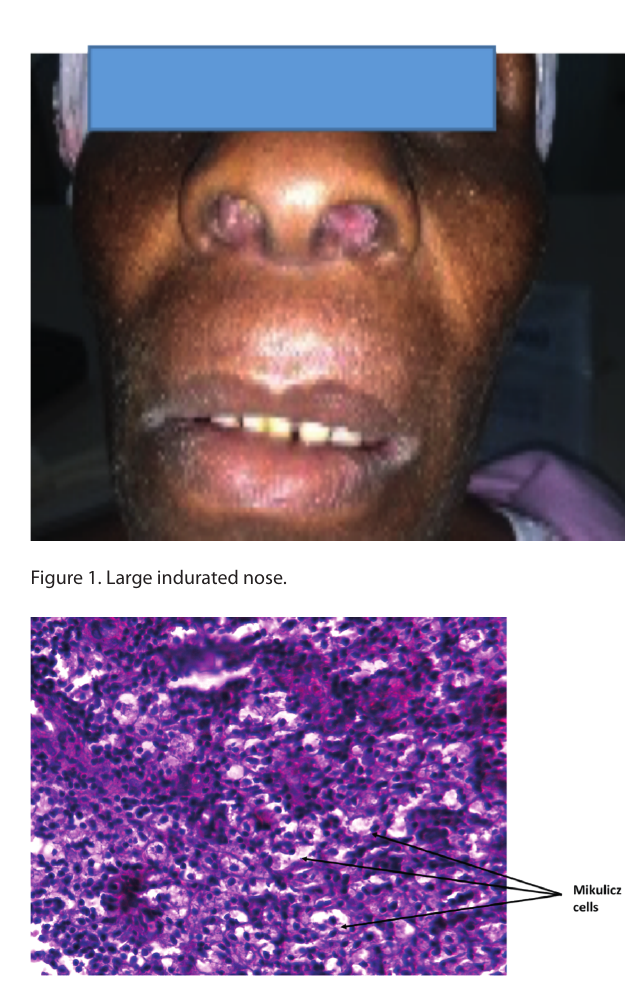
Figure 2. Histology: HE × 400 showing an ulcerated squamous mucous replaced by a polymorphous granulation tissue. The chorion is the seat of Mikulicz cells